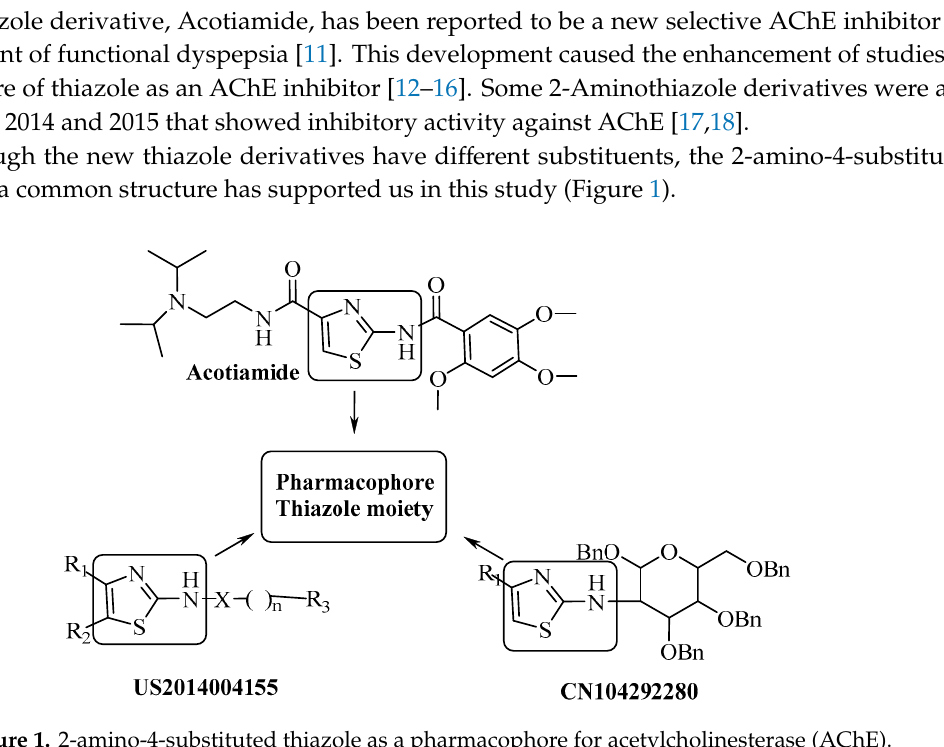
Figure 1. 2-amino-4-substituted thiazole as a pharmacophore for acetylcholinesterase (AChE).